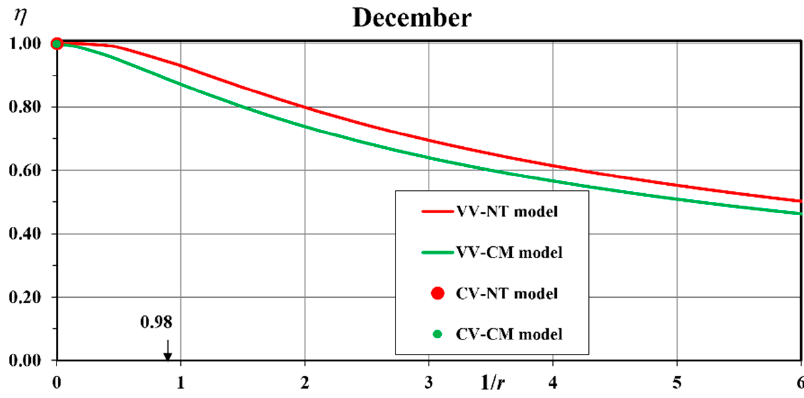
Figure 6. Annual trapping capacity ( η ) of the Lobo reservoir.